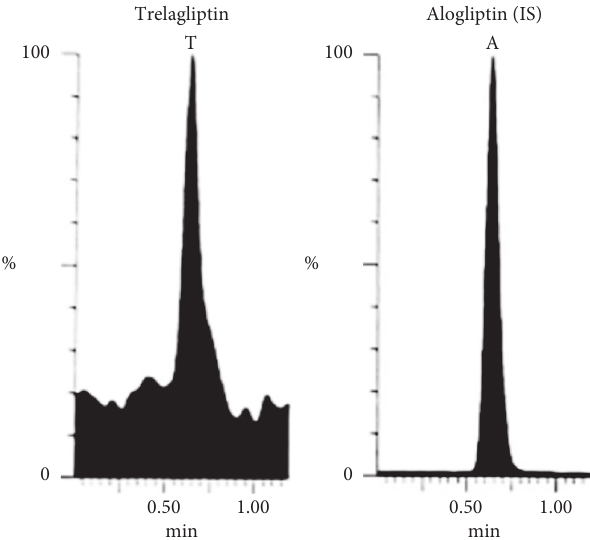
Figure 7: LLOQ sample (4nMol/L of TLN) usingMRM, (m/z � 358.2 to 133.9) and (IS, m/z � 340.2 to